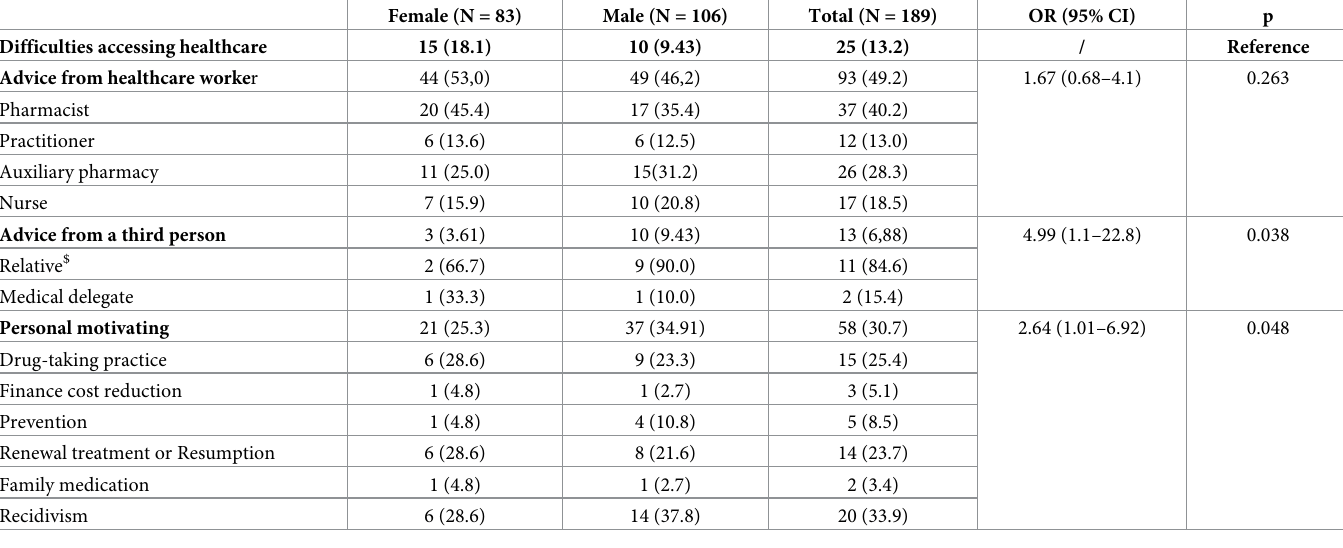
Table 3. Sources of self-medication among patients concerned with the antibiotics and reasons for the antibiotics